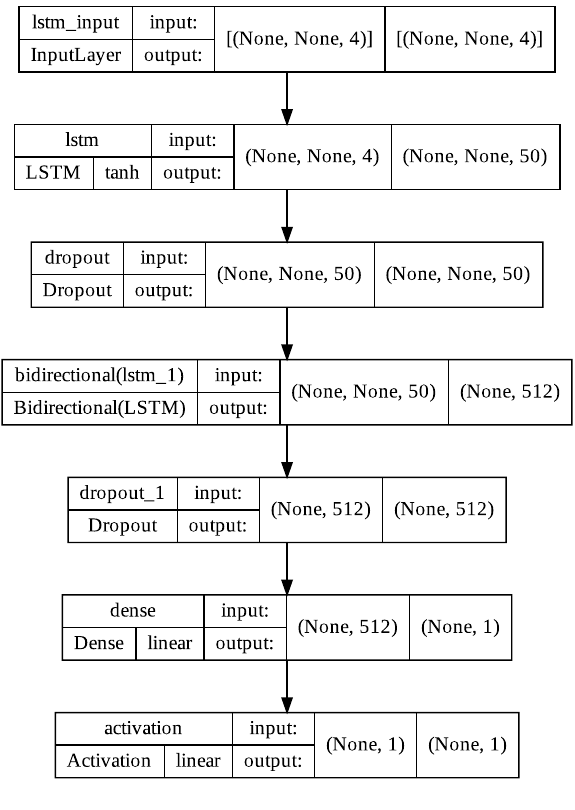
Fig. 7 A graphical presenta- tion of the hierarchy of the GRU model using a sequence length of 50. The graph is generated from